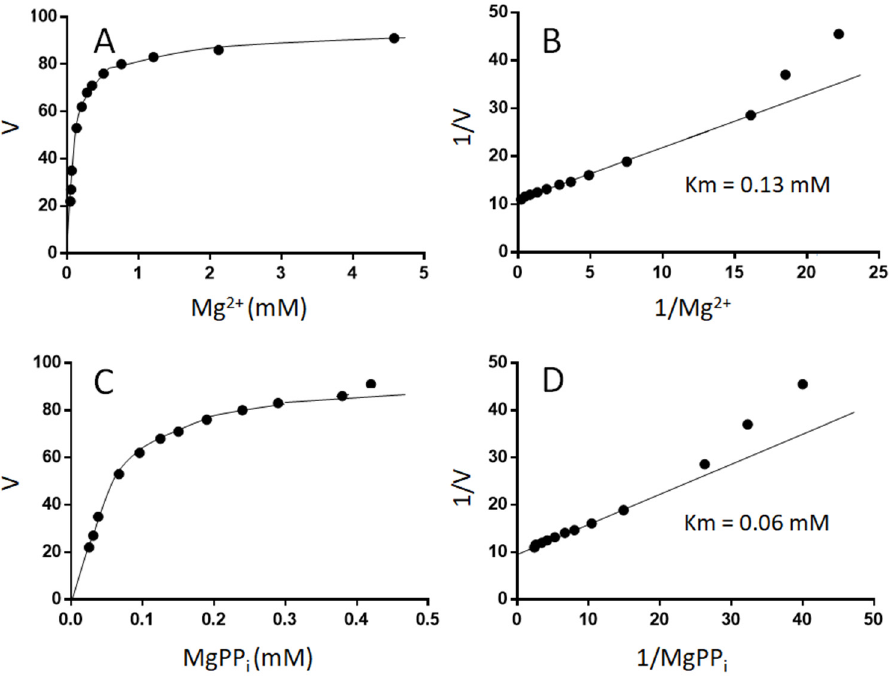
Figure 2. Effects of Mg 2+ and MgPP i on activity of barley UGPase in its pyrophosphorolytic reaction. ( A ) UGPase activity (V) versus [Mg 2+ ]; ( B ) Double reciprocal plot for data in panel ( A ); ( C ) UGPase activity (V) versus [MgPP i ]; ( D ) Double reciprocal plot for data in panel ( C ).